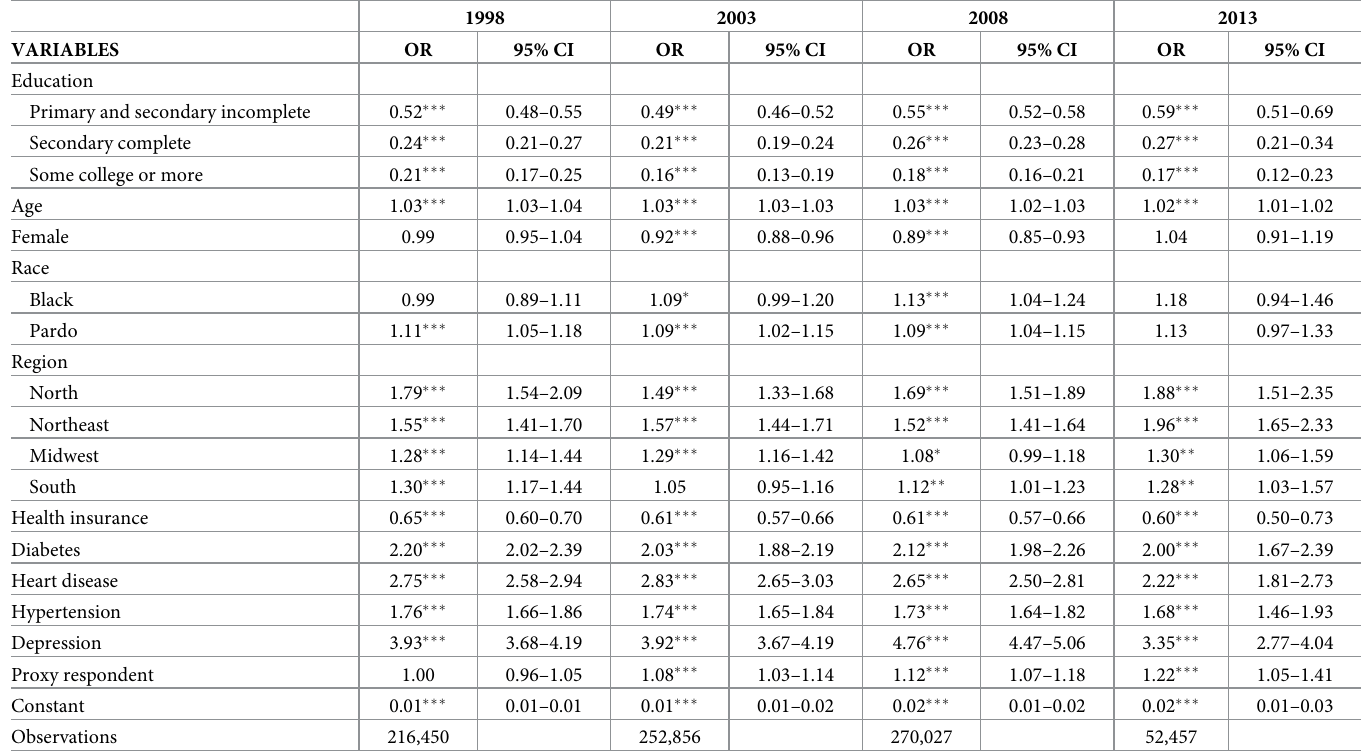
Table 3. Odds-ratios and 95% confidence intervals examining the association between educational levels and poor self-rated health, Brazil: